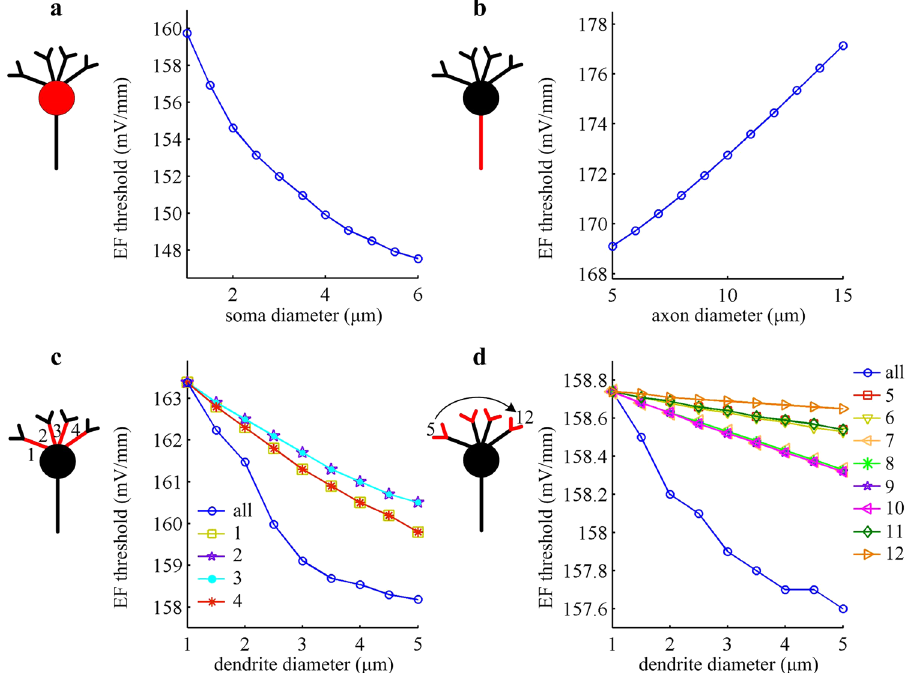
Figure 2. EF firing threshold changes with compartment diameter in artificial model. EF threshold for triggering APs is respectively showed as a function of the diameter of ( a ) soma, ( b ) axon, ( c ) proximal dendrites, and ( d ) distal dendrites. The length of relevant compartment takes the initial